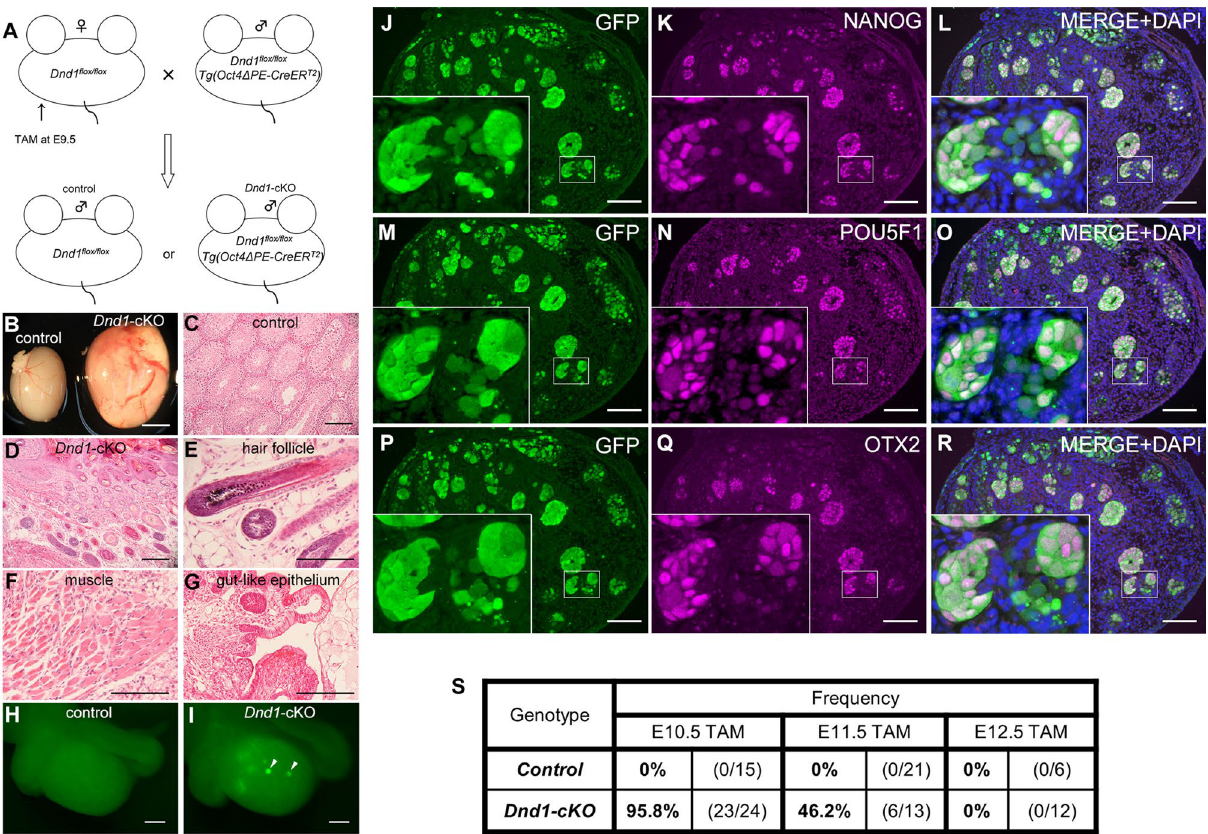
Figure 1. Dnd1 deletion in migrating PGCs causes testicular teratomas. ( A ), Mating strategy for the generation of conditional knockout mice of Dnd1 . ( B ), Comparison of testis size between 4-week-old littermates of control ( Dnd1 flox/flox ) and Dnd1 -cKO ( Dnd1 flox/flox ; Oct4ΔPE-CreER T2 ) mice. ( C – G) , Testis sections from 4-week-old control ( C ) and Dnd1 -cKO ( D – G ) mice were stained with haematoxylin and eosin. Hair follicles, muscles, and gut-like epithelium are observed in ( E , F ), and ( G ), respectively. ( H , I ), Testis from control ( H ) and Dnd1 -cKO ( I ) embryos with Nanog-GFP transgene at E16.5, under a fluorescence microscope. The arrowheads in ( I ) indicate GFP-positive foci. ( J – R ), Testis sections from E16.5 Dnd1 -cKO embryos with Nanog-GFP transgene were immunostained with antibodies against GFP ( J , M , P ), NANOG ( K ), POU5F1 ( N ), and OTX2 ( Q ). DNA was labelled with DAPI (blue) ( L , O , R ). Images correspond to one of n = 3 biological replicates. S , The incidence of male embryos with at least one ECC colony in the testes was analysed in control and Dnd1 -cKO embryos with Nanog-GFP transgene after injection of tamoxifen at E10.5, E11.5, and E12.5. Scale bars: 5 mm in ( B ), 100 μm in ( C ) and ( D ), 100 μm in ( E – G ), 200 μm in ( H ) and ( I ), and 100 μm in ( J – R